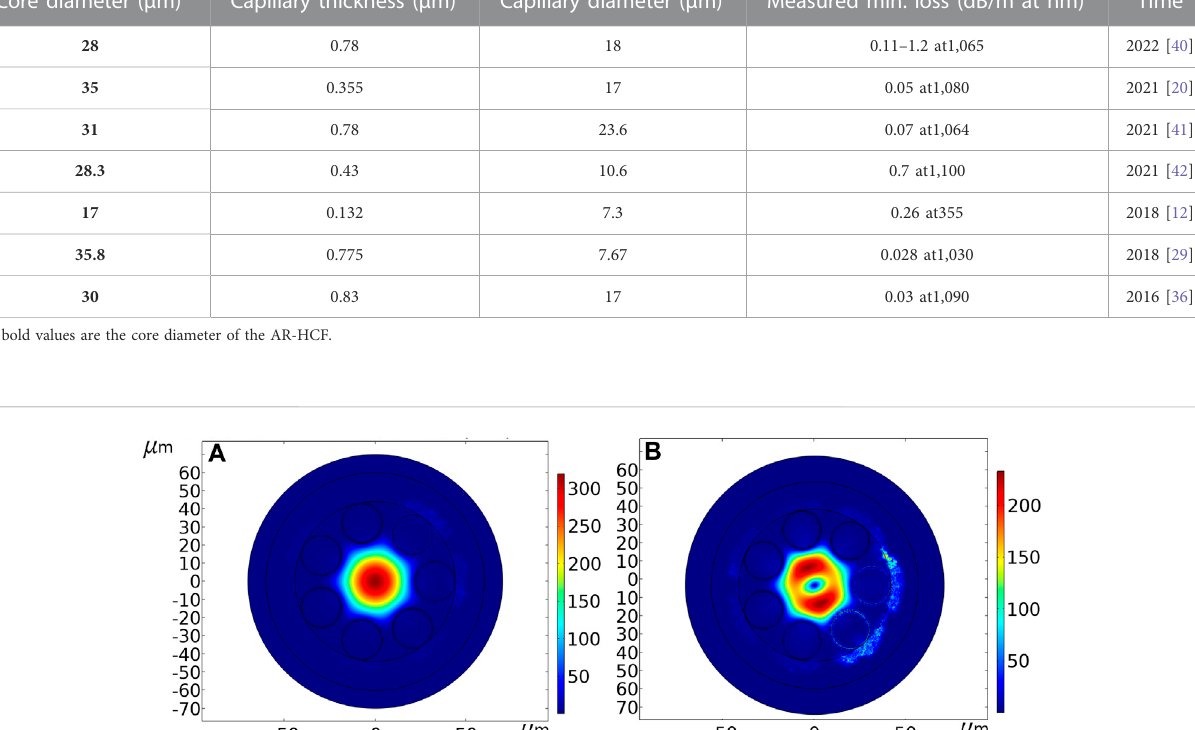
TABLE 1 Performance comparison of recently reported attenuation of seven capillaries AR- HCFs. Core diameter ( μ m)